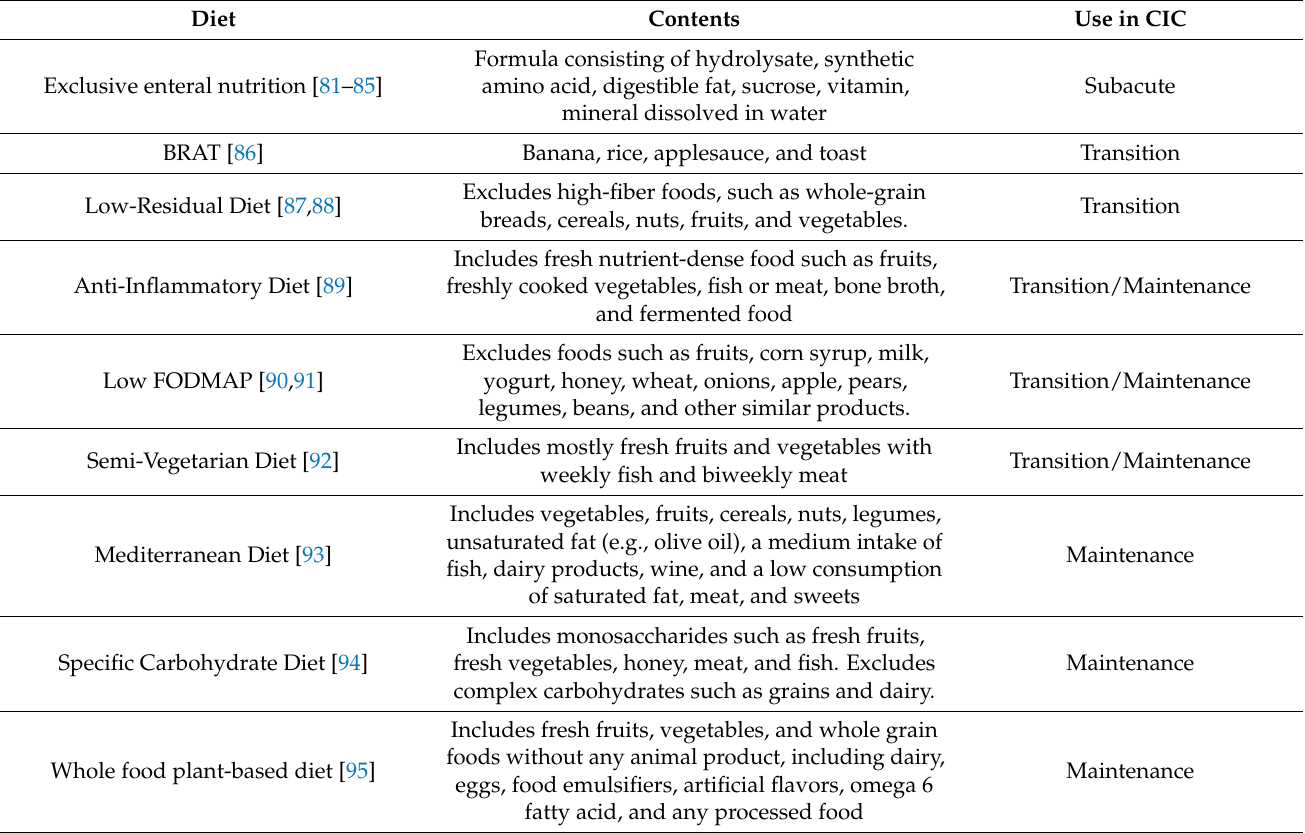
Table 3. Dietary recommendations in